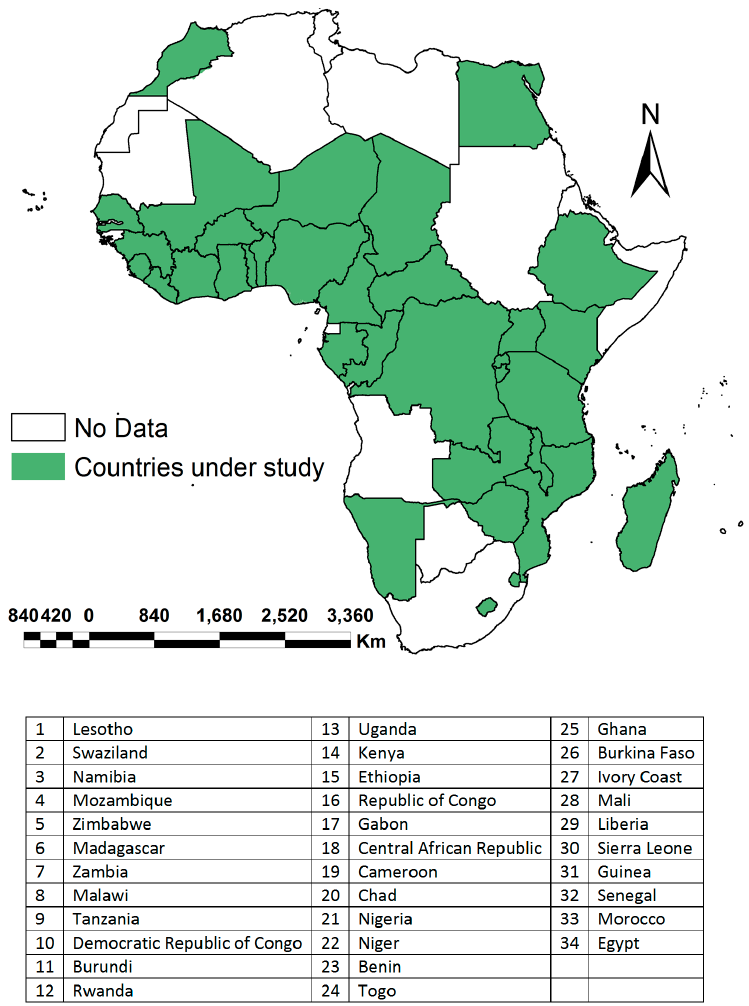
Figure 1. Study area.